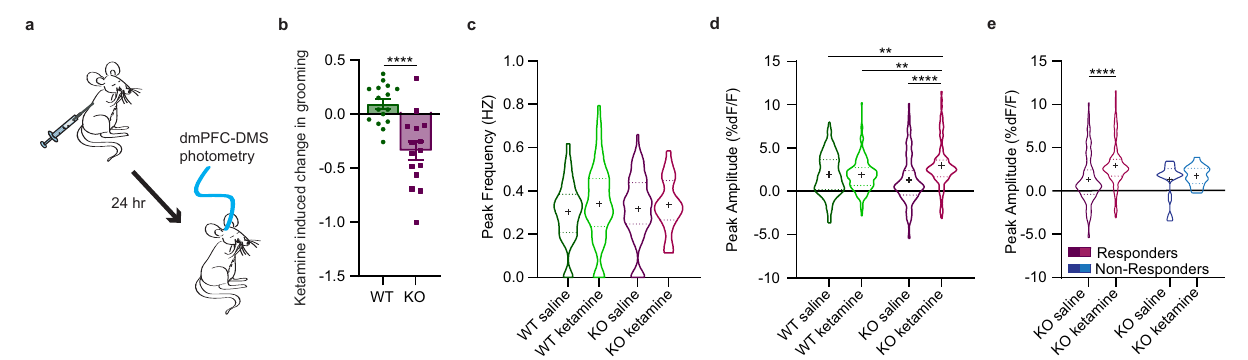
Fig. 3 Effect of ketamine on fronto-striatal circuit activity. a Schematic showing fi ber photometry recording of dmPFC-DMS projection neurons 24 h after mice are injected with saline or ketamine. b KO mice show a signi fi cant decrease in grooming duration compared to WT mice after ketamine injection (unpaired two-tailed t test P < 0.0001, WT = 16 animals, KO = 15 animals). c No change in the frequency of calcium transients between saline and ketamine groups (two-way ANOVA; interaction P > 0.05, genotype P > 0.05, drug P > 0.05; WT = 66 saline groom epochs and 70 ketamine groom epochs from 11 animals, KO saline = 69 groom epochs from 10 animals, KO ketamine = 25 groom epochs from 9 animals). d Ketamine signi fi cantly increases the amplitude of calcium transients during grooming epochs in KO animals but not WT animals 24 h post-injection (two-way ANOVA: interaction P < 0.0001, drug P < 0.0001, genotype P > 0.05; Tukey ’ s multiple comparisons: WT saline vs KO ketamine P = 0.0047, WT ketamine vs KO ketamine P = 0.0020, KO saline vs KO ketamine P < 0.0001; WT = 66 saline groom epochs and 70 ketamine groom epochs from 11 animals, KO saline = 69 groom epochs from 10 animals, KO ketamine = 25 groom epochs from 9 animals). e Ketamine does not signi fi cantly increase amplitude of calcium transients during grooming epochs in KO mice that do not have a reduction in grooming behavior post-ketamine (two-way ANOVA; interaction P > 0.05, treatment P = 0.0160, responder-type P > 0.05; Tukey ’ s multiple comparisons: responders, KO saline vs KO ketamine P < 0.0001; responders, KO saline = 69 groom epochs from 10 animals, KO ketamine = 25 groom epochs from 9 animals; non-responders, KO saline = 6 groom epochs from 2 animals, KO ketamine = 10 groom epochs from 2 animals). Bar graphs and PETHs show data means + / − SEM. Truncated violin plots end at distribution minimum and maximum, dotted lines mark 25% and 75% quartiles, cross denotes data means. Source data are provided as a Source data fi le. ** P < 0.01, **** P <